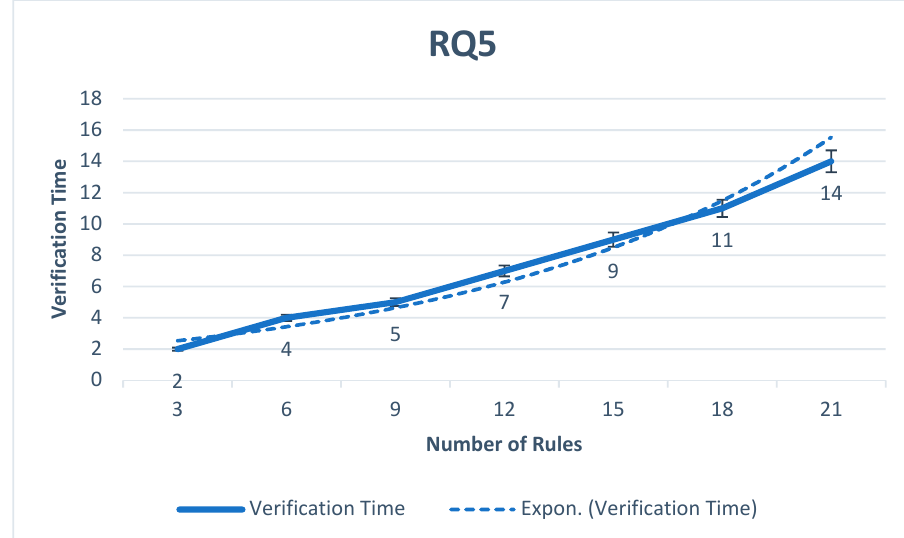
Expon. (Verification Time)